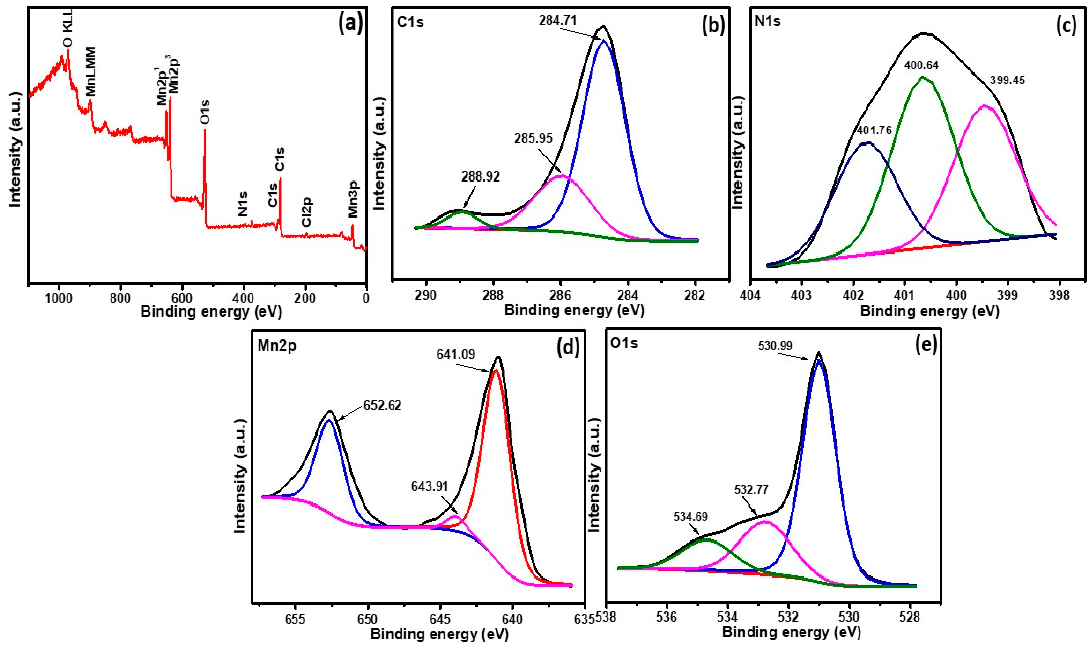
Figure 4. ( a ) A survey spectrum of PANI@CNT/MnO 2 ternary composite, core-level XPS spectra of ( b ) C 1s, ( c ) N 1s, ( d ) Mn 2p and ( e ) O 1s.